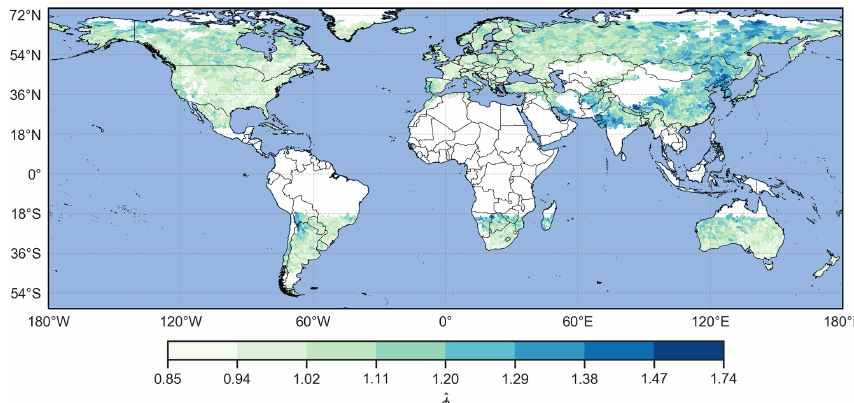
Figure E1. Index of dispersion ˆ φ by catchment, for r = 2d, t = 99p and w = 21d. ˆ φ > 1 denotes catchments where extreme precipitation events are more clustered than